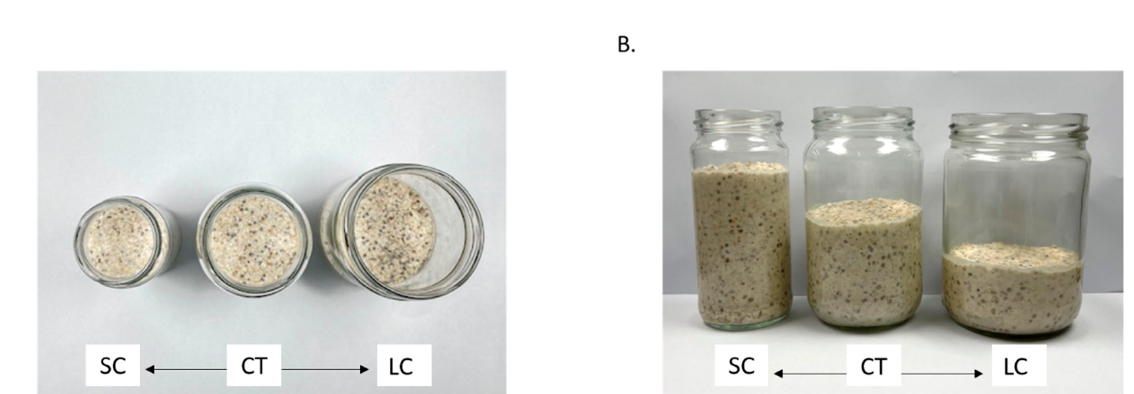
Figure 1. Demonstration of the top view ( A ) and the side view ( B ) of the jar sizes used in the study. Small jar size condition (SC) was 5.7 cm in diameter (volume = 9.9 oz), medium jar size condition (control, CT) was 7.3 cm in diameter (volume = 16.3 oz), and large jar size condition (LC) was 8.9 cm in diameter (volume = 24.2 oz). The three jars displayed in the figure contained 226 g of oat pudding—a portion averaged across all